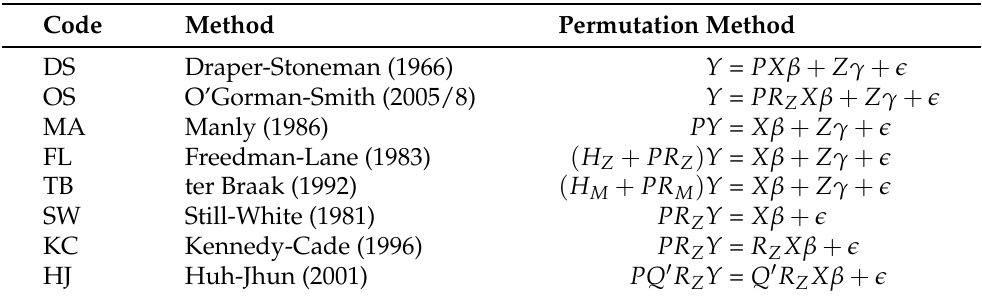
Table 1. Permutation methods for testing H 0 : β = 0 p in the presence of the nuisance parameters γ . The intercept α is excluded from each model for notational